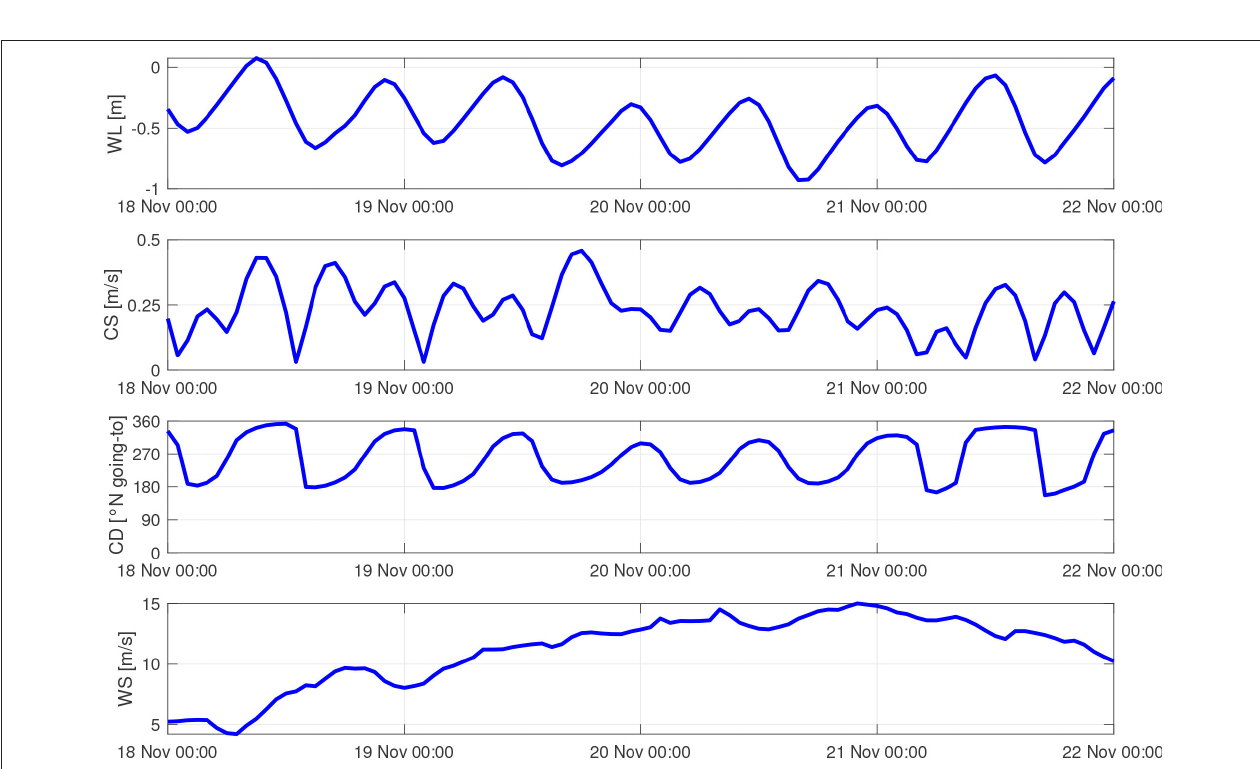
FIGURE 2 | Spatial domain and mesh resolution adopted in the simulations. Color scale is for water depth in meter.